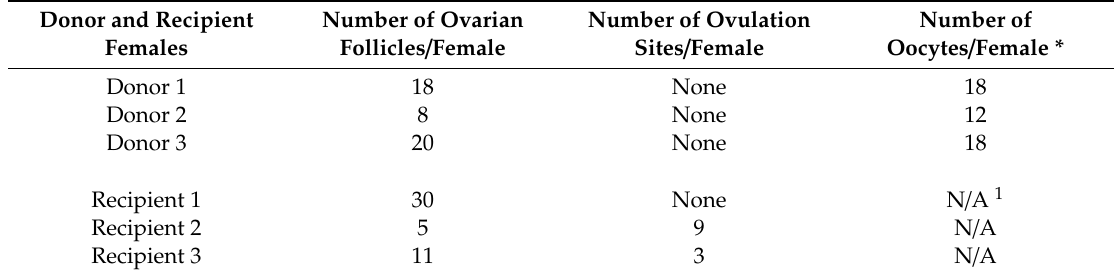
Table 2. Ovarian and oocyte metrics from donor and recipient cheetah females.